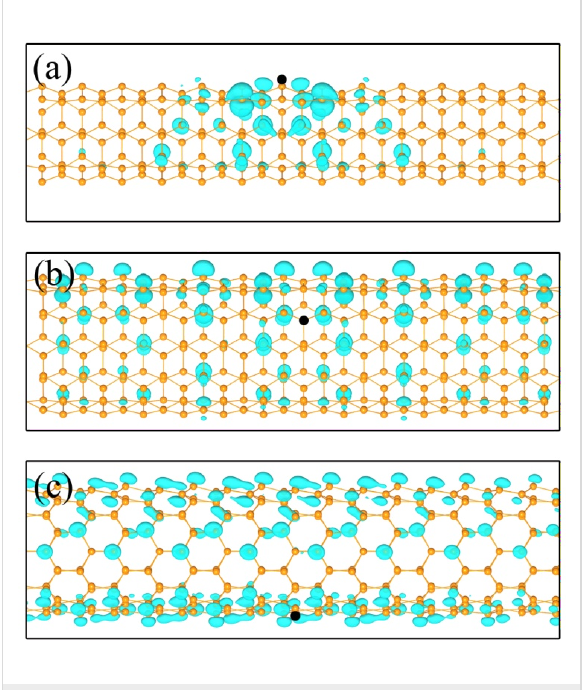
Figure 5: Electron probability distribution | ψ ( r e ; r h )| 2 for finding the electrons r e with the hole position r h (black dot) fixed slightly above a Si atom for the bound excitonic state of silicon nanotubes (4,4) (a); (6,6) (b) and (10,0) (c).